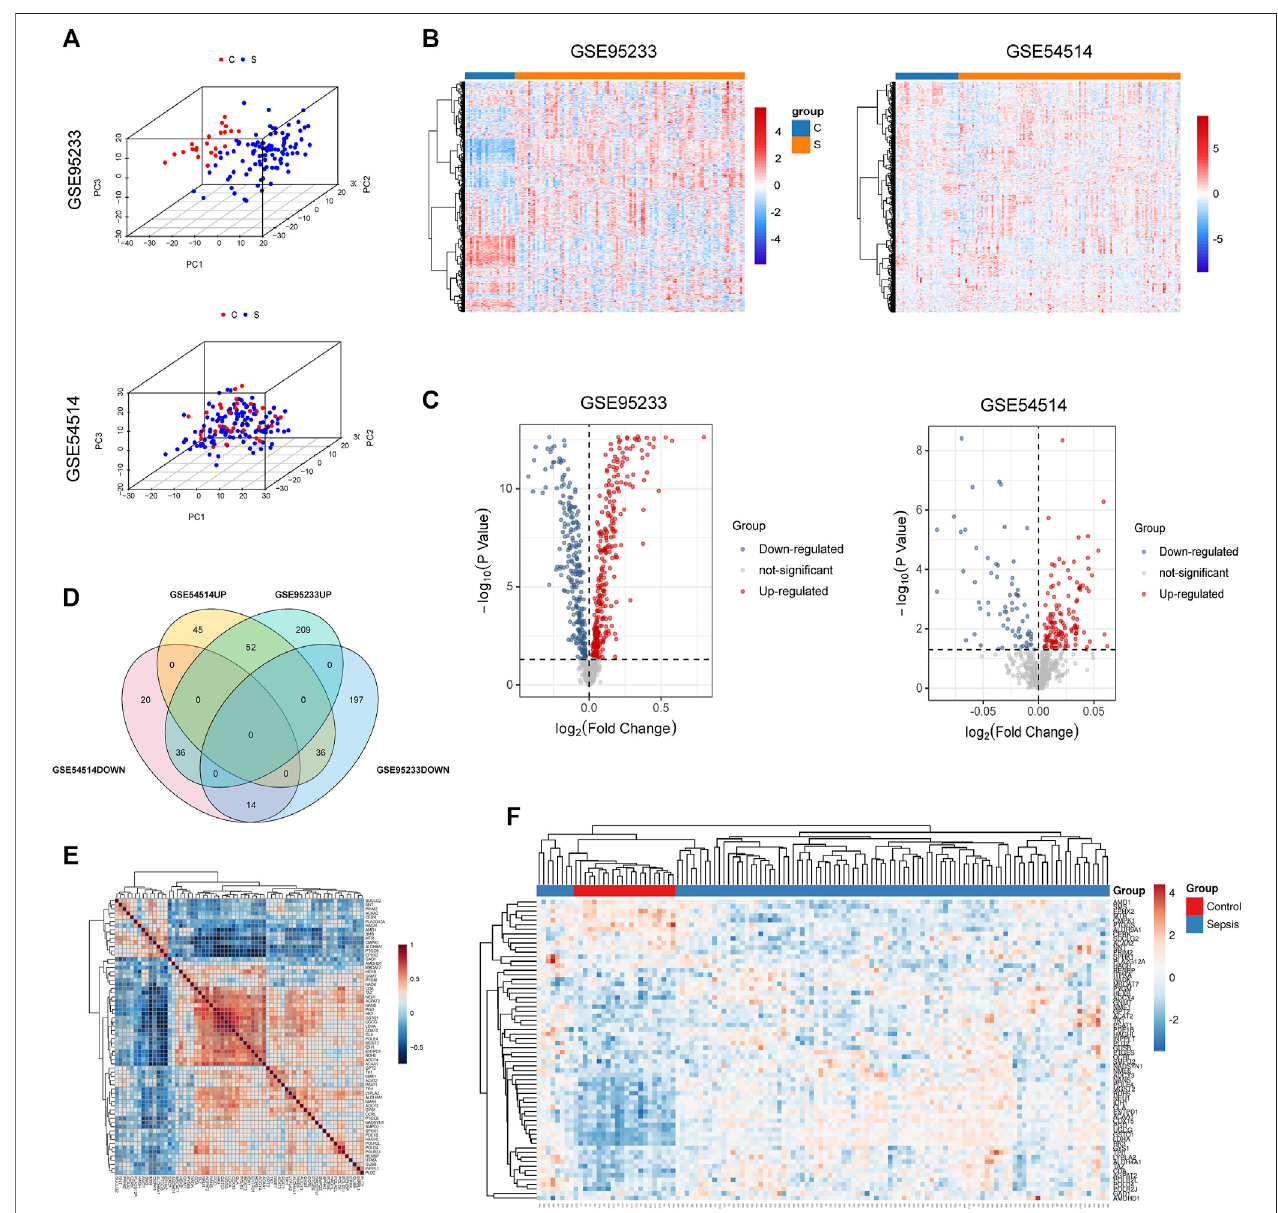
FIGURE1| Metabolism-relatedgenesareamongDEGsfoundinsepsispatientversushealthycontrolwholeblood. (A) Principalcomponentsanalysis(PCA)score plotofGSE95233andGSE54514.Redrepresentscontrolpatients,andbluerepresentssepsispatients. (B) HeatmapofGSE95233andGSE54514. (C) Volcanoplotof GSE95233 and GSE54514. Gray dots indicate downregulated DEGs while red dots indicate upregulated DEGs. Statistically signi fi cant DEGs were identi fi ed as those with Student ’ s t-test p -values < 0.05. (D) Venn diagram of DEGs identi fi ed from the two GEO datasets (-UP: upregulated DEGs, -DOWN: downregulated DEGs). (E) Co-expression network of the differentially expressed metabolism-related genes identi fi ed from GSE95233. Red depicts high gene expression and blue depicts low gene expression. (F) Heatmap of the 66 DEGs between patients with sepsis and healthy controls in the training cohort GSE95233.